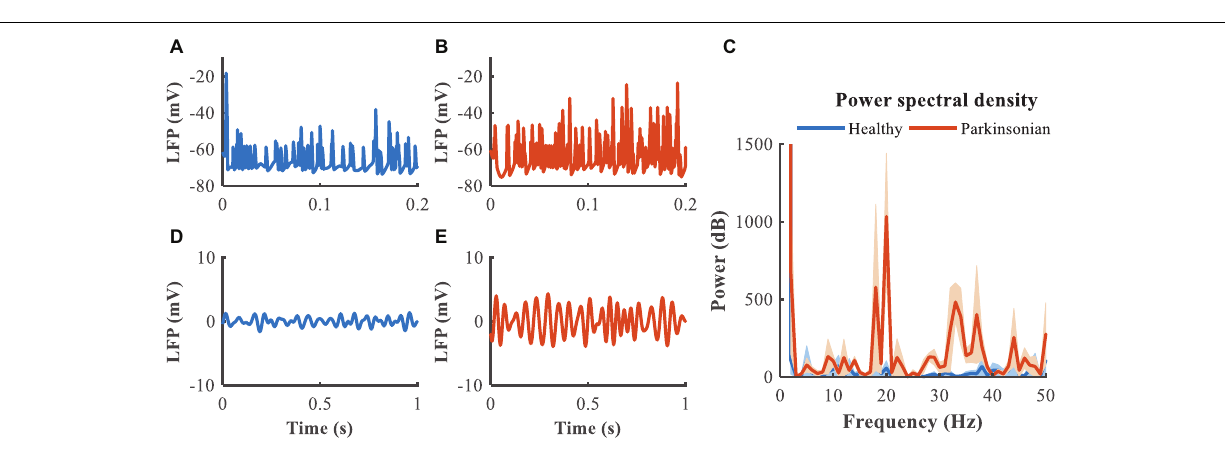
FIGURE 5 | Local field potential (LFP) activity from model neurons in the GPi. In panels (A,B) , blue trace depicts the LFP in the healthy state while the orange trace depicts the LFP in the Parkinsonian state. Panel (C) illustrates the power spectral density of the GPi LFP across 10 trails to quantify the corresponding oscillatory activity, where shaded error region represents standard errors. Panels (D,E) depict the band-pass filtered (13–30 Hz) LFP activity in the